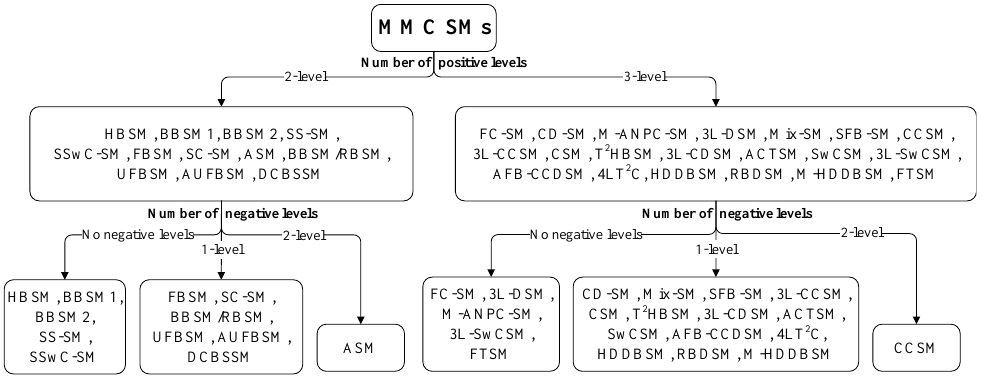
Figure 14. Classification of SMs based on number of positive and negative levels in their output